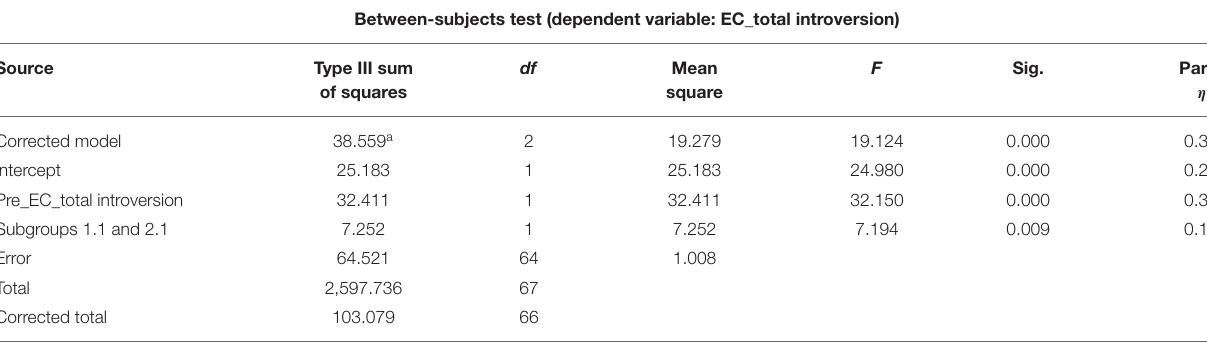
TABLE 3 | ANCOVA results for emotional competences development (ECD): close to experience.